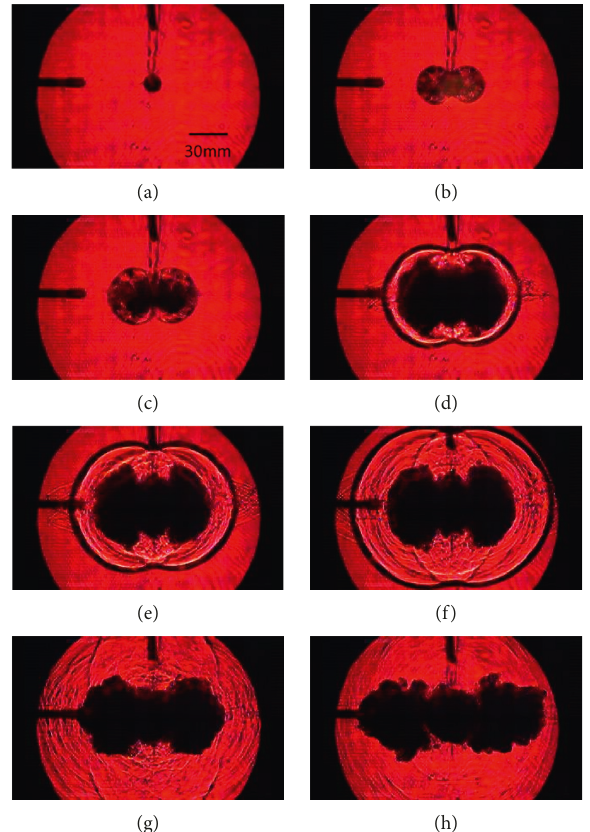
Figure 4: Process picture of slotted cartridge blast wave. (a) 0 μ s. (b) 20 μ s. (c) 60 μ s. (d) 120 μ s. (e) 160 μ s. (f) 220 μ s. (g) 330 μ s. (h) 560 μ